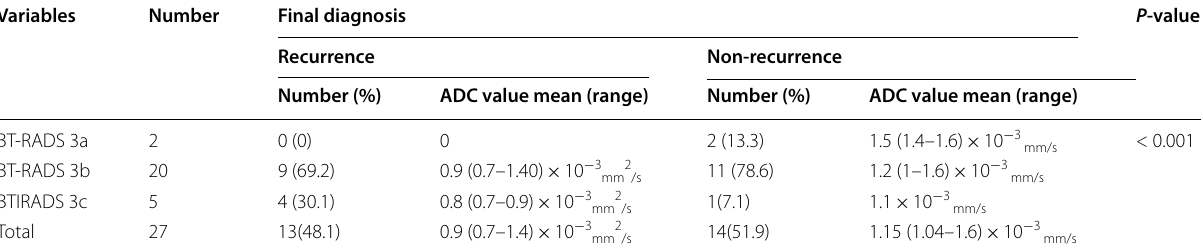
among recurrent and non-recurrent glioma patients mean